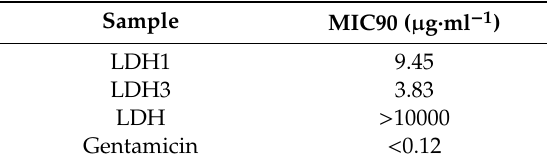
Table 4. Antibacterial activity (MIC90) of LDH1 and LDH3 catalysts.